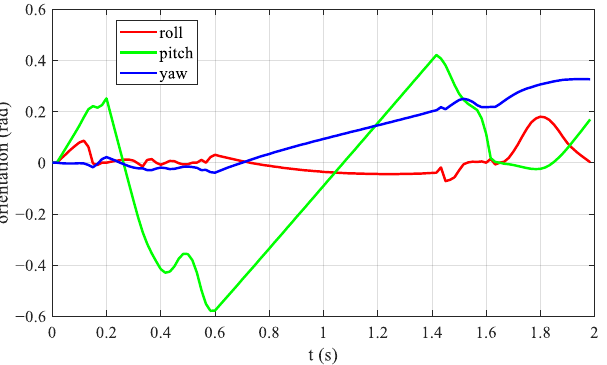
Figure 11. Quadruped robot’s RPY angle. The red curve is the change in the roll angle, the green curve is the change in the pitch angle, and the blue curve is the change in the yaw angle.